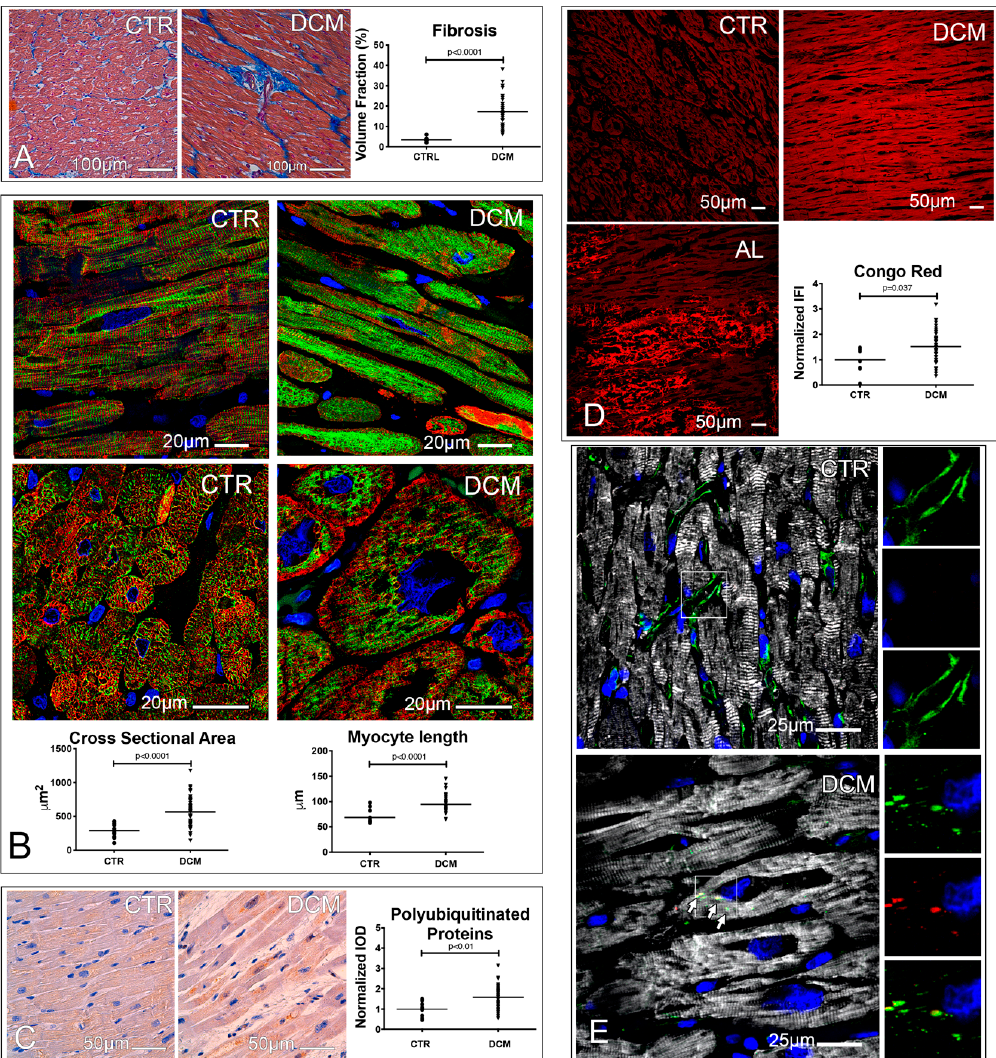
Figure 1. Fibrosis, hypertrophy, and loss of proteostasis characterize the hearts of dilated cardiomyopathy (DCM) patients. ( A ) Fibrosis. Microimages of trichrome stained control and diseased hearts, showing interstitial and perivascular fibrosis (blue). Dot plots indicate the volume fraction occupied by fibrosis; an unpaired t test was employed. ( B ) Hypertrophy. Confocal images of cardiac sections showing α -sarcomeric actin (ASA, red) and desmin (green) stained cardiomyocytes. Cardiomyocyte cross-sectional area and length are shown in dot plots; unpaired t test and Mann–Whitney test, respectively, were employed. ( C – E ) Protein misfolding. Microimages of polyubiquitinated protein labeled cardiac sections (brown). Normalized integrated optical density (IOD) values, obtained dividing individual IOD values by the mean IOD of controls, of the immunohistochemistry staining are shown in dot plots; an unpaired t test was employed ( C ). Confocal images of Congo red (CR) stained cardiac sections of control, DCM, and AL amyloidosis (AL) patients. CR was excited with a UV laser, while the fluorescence emission range was set at 596–615 nm employing a monochromator. The integrated fluorescence intensity (IFI) values of CR, normalized as IOD, are shown in dot plots; a Mann–Whitney test was employed ( D ). Confocal images showing the presence of aggresomes. ASA (white) labels cardiomyocytes, while vimentin decorates both interstitial cells and aggresomes (green), these latter being characterized by the co-localization of vimentin and p62 SQSTM1 (red). Images of either vimentin, p62 SQSTM1 , or the combination of the two stainings without ASA are shown in the right portion of each figure ( E ). Nuclei of fluorescence images are stained in blue by 4 (cid:48) ,6-diamidine-2 (cid:48) -phenylindole dihydrochloride (DAPI). A total of 18 controls and 50 DCM hearts were